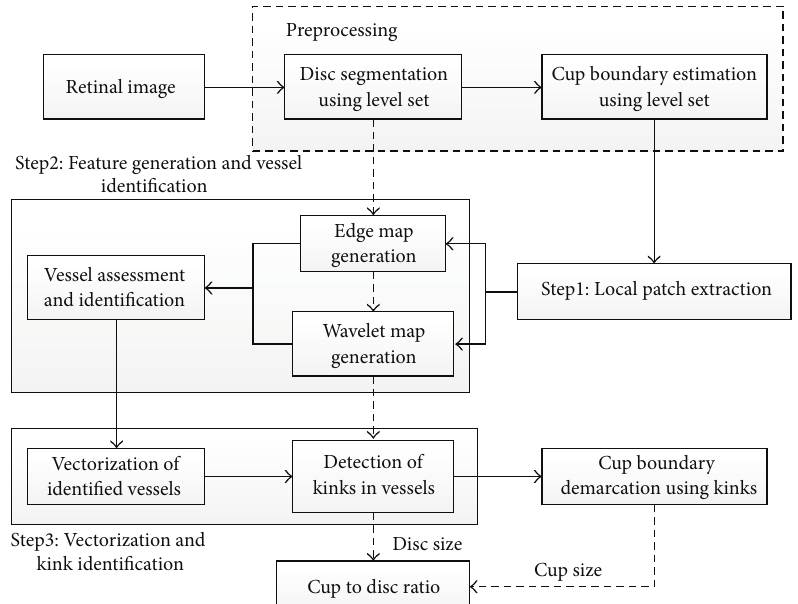
Figure 26: Flowchart for algorithm proposed in [59].